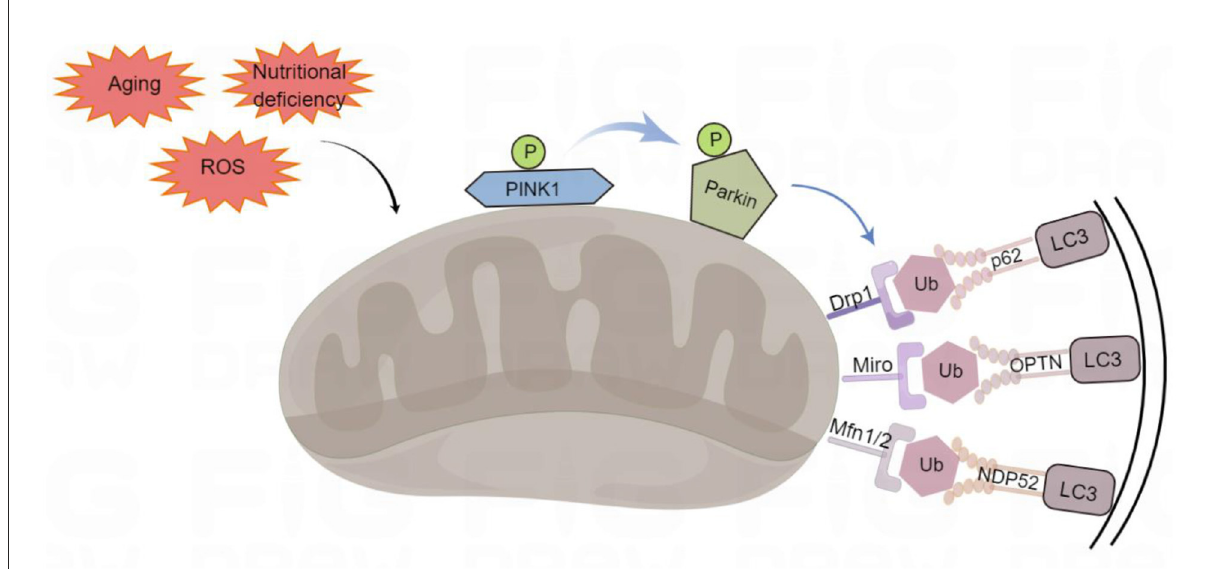
FIGURE1 Ubiquitin-dependent mitophagy. PTEN-induced putative kinase 1 (PINK1) recognizes the damaged mitochondria, recruits Parkin to the damaged mitochondrial outer membrane, and phosphorylates it. Parkin can ubiquitinate proteins on the outer mitochondrial membrane, such as Mfn1/2 (mitofusins 1 and 2), Drp1 (dynamin-related protein 1), and Miro (mitochondrial Rho) to form polyubiquitin chains, which act as an “eat-me” signal for the autophagy mechanism to signal p62/SQSTM1 (sequestosome 1), optineurin (OPTN), and NDP52 (nuclear dot protein